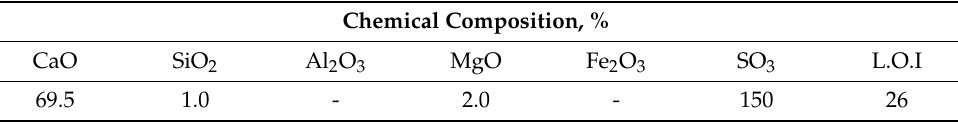
Table 4. Chemical properties of hydrated lime.